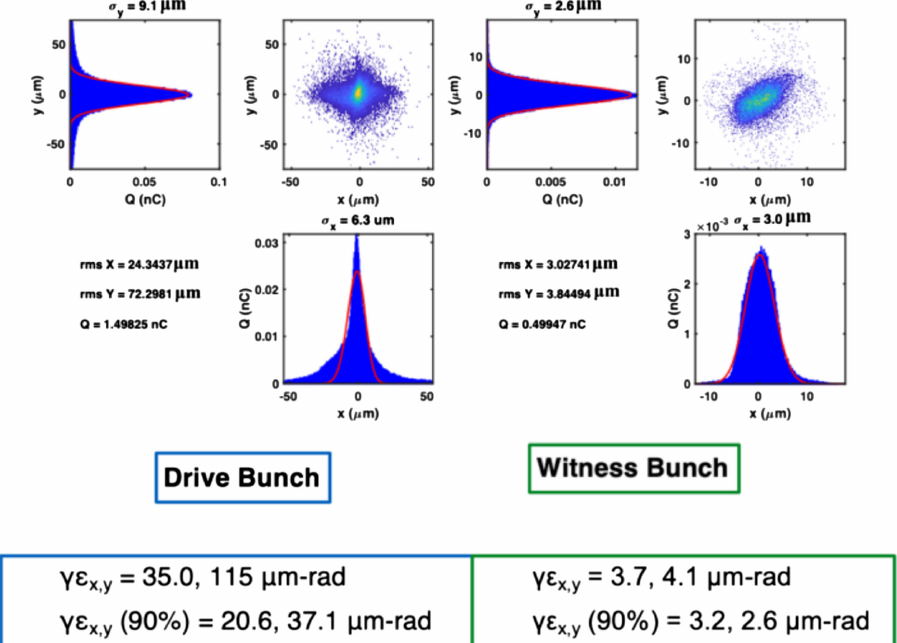
FIG. 9. Tracked transverse two-bunch mode particle distributions at sector 20 interaction point for the leading “ drive ” bunch and trailing “ witness ”